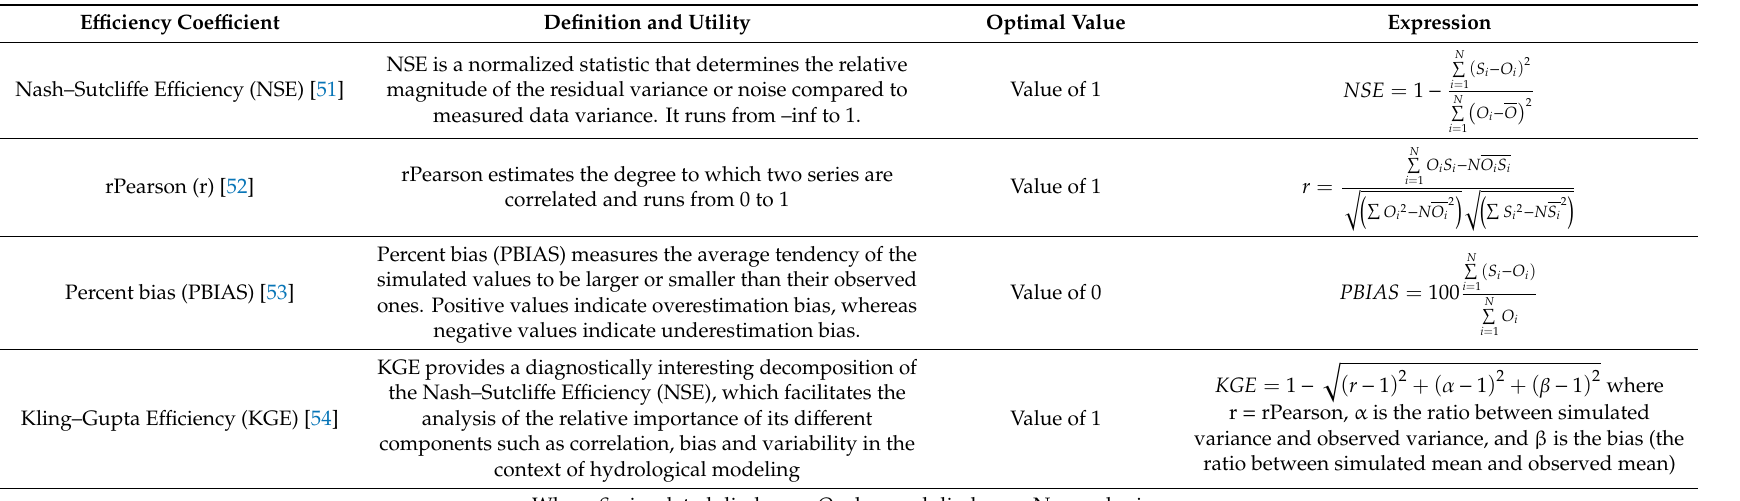
Table 4. Model performance